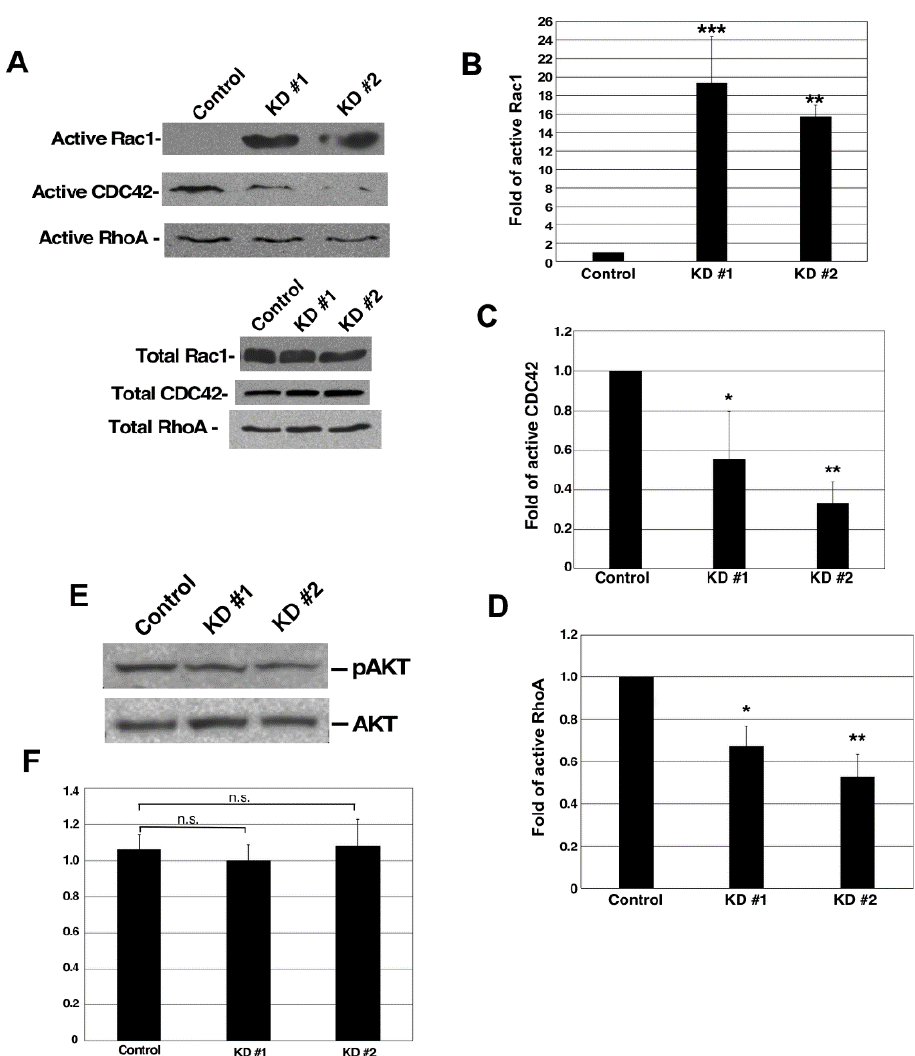
Figure 6. mGBP-2 inhibits the activation of Rac1 and promotes the activation of CDC42 and RhoA. ( A ) Control, KD #1, and KD #2 67NR cells were serum starved for 12 h and then incubated with 20% FBS in DMEM for 30 min, lysed, and analyzed for active Rac1, CDC42, and RhoA as described in Methods. ( B – D ) Immunoblots from PBD pulldowns were quantified and results for levels of each active Rho protein were normalized to their total cellular level and then set to 1 for control 67NR cells (*, p < 0.05; **, p < 0.01; ***, p < 0.001 compared to control cells; n = 3). Representative western blots are shown. ( E ) Control, KD #1, and KD #2 67NR cells were serum-starved for 18 h and then incubated with 20% FBS in DMEM for 30 min. Cell lysates were analyzed for phospho-Akt and total Akt. A representative blot is shown. ( F ) Scanned X-ray films were uploaded into Image J to measure densitometric values of pAkt and total Akt. The ratio of pAkt and total Akt densitometric values were calculated and represented on the graph as the average pAkt ± SD relative to control, which was assigned an arbitrary value of 1 ( p = 0.7617 compared to control cells, n = 2).